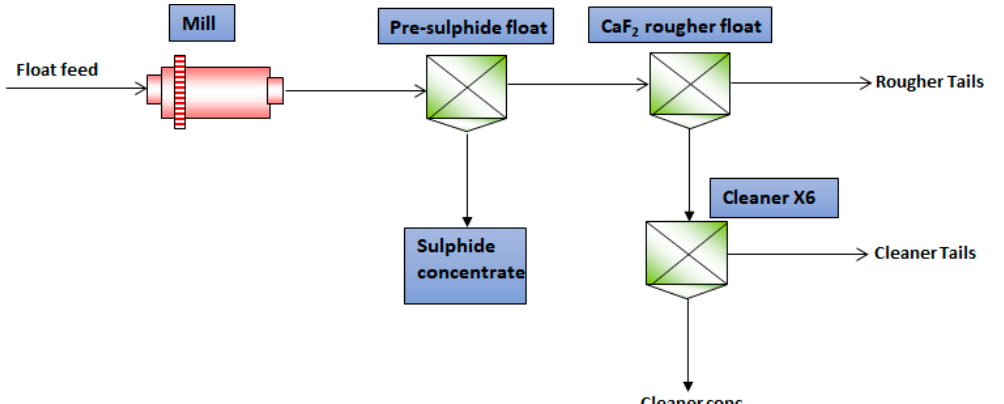
Figure 3. Flowsheet for the processing of ore B, which includes a pre-sulphide flotation stage, fluorite roughing and sequential cleaning.